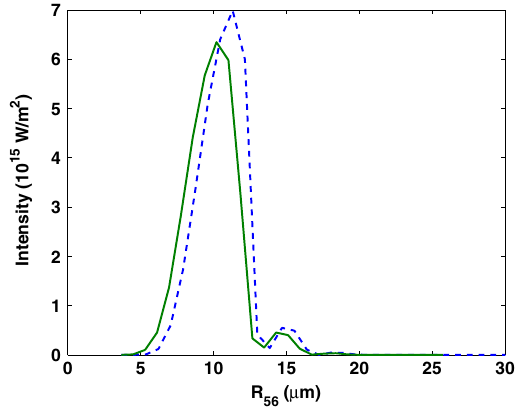
FIG. 3. The map (dashed line) shows qualitative agreement with simulations (solid line) of the saturated intensity from the radiator for a scan of chicane